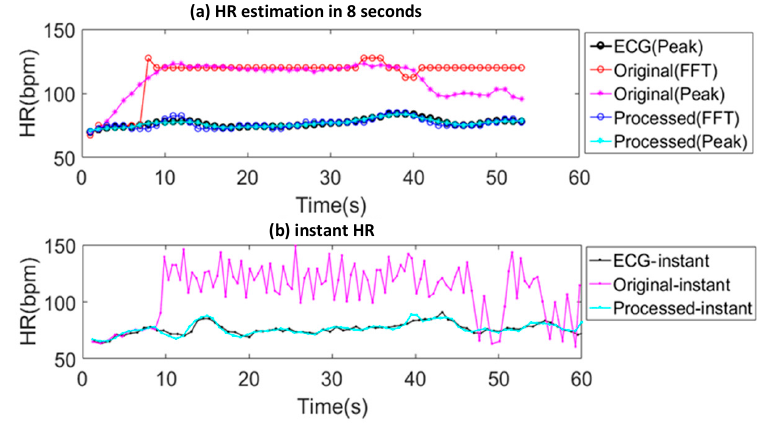
Figure 11. ( a ) The average HRs obtained by ECG, original signal with bandpass filtering and the processed signal using the framework; ( b ) The instant HRs obtained by ECG, original signal with bandpass filtering and the processed signal using the framework.